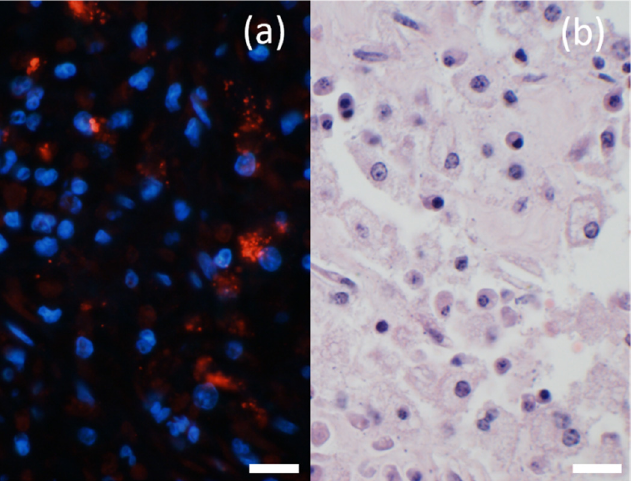
Figure 3. Detection of streptococcus in the abscess. ( a ) Numerous streptococci (red) were identified within cells via immunofluorescence. Nuclei of cells were detected with the DNA-binding dye DAPI (blue). 600 × g magnification, bar = 20 µ m. ( b ) Consecutive slide. Most of the cells were morphologically identified as macrophages. HE 600 × g magnification; bar = 20 µ m.